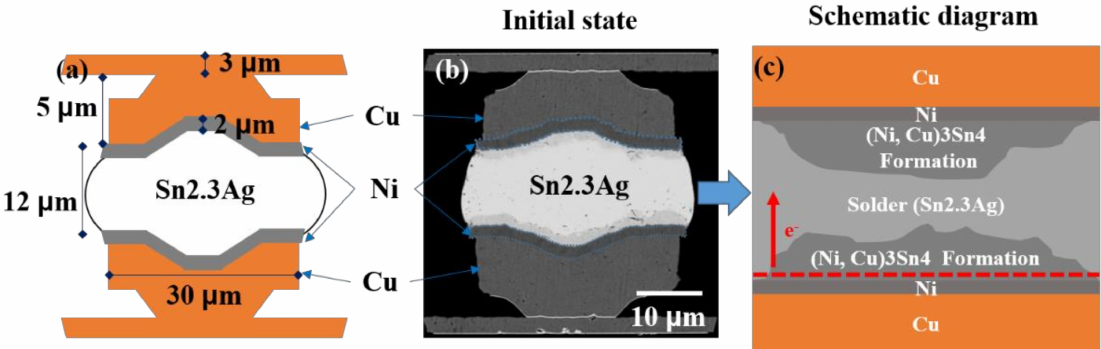
Figure 2. Dimension and structure of the solder microbumps used in this study: ( a ) schematic drawing of the SnAg microbumps; ( b ) as-fabricated SnAg microbump with Ni/Cu UBM. ( c ) Schematic diagram of the microbumps showing the induced phases and atomic diffusion of Ni flow under EM stressing.